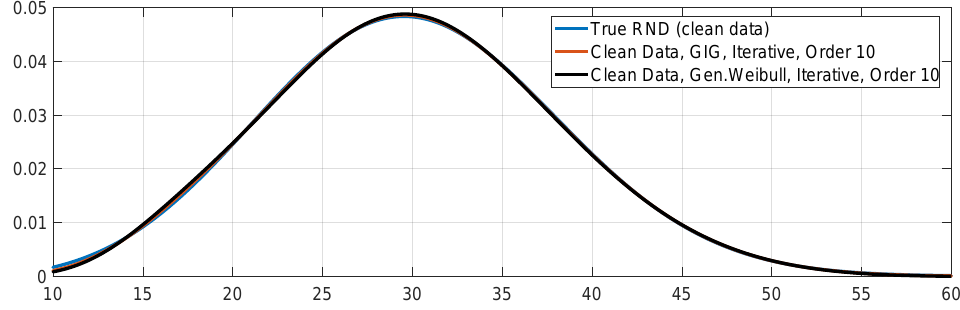
Figure 7. True and fitted RNDs based on the modified CIR density in (14). The data is generated with parameters k = 1.71, ζ = 0.097, η = 0.577 and τ = 30/365. The fitted RNDs are obtained with a GIG and GW kernels for n =